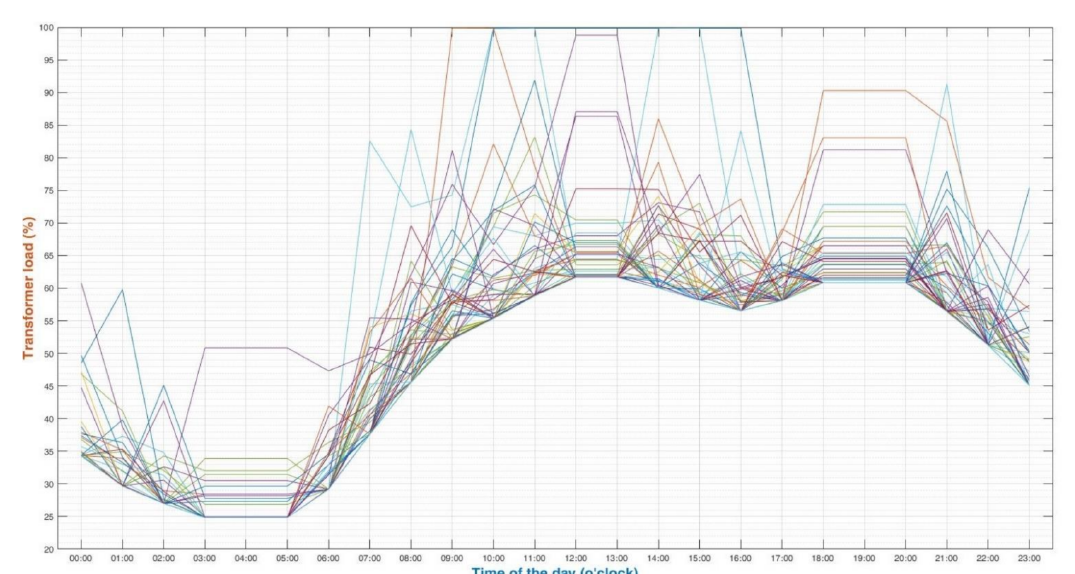
Figure 15. Capacity congestion of the transformers when CS2 (case 1) is applied.